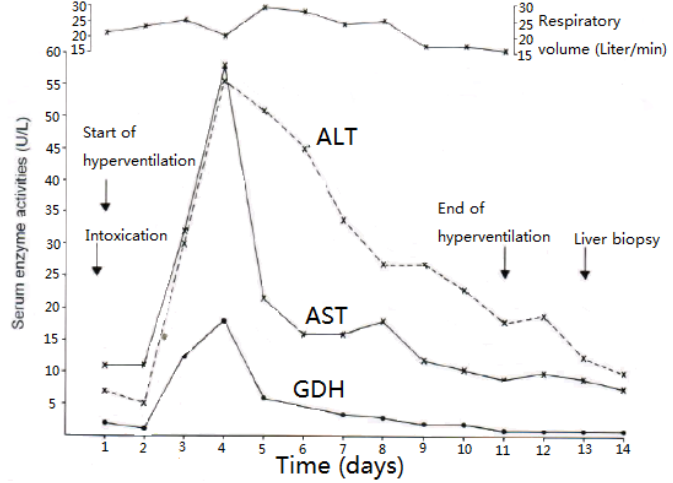
Figure 5. Patient 1 after ingestion 30 mL CCl 4 and serum activities of AST, ALT, and GDH under